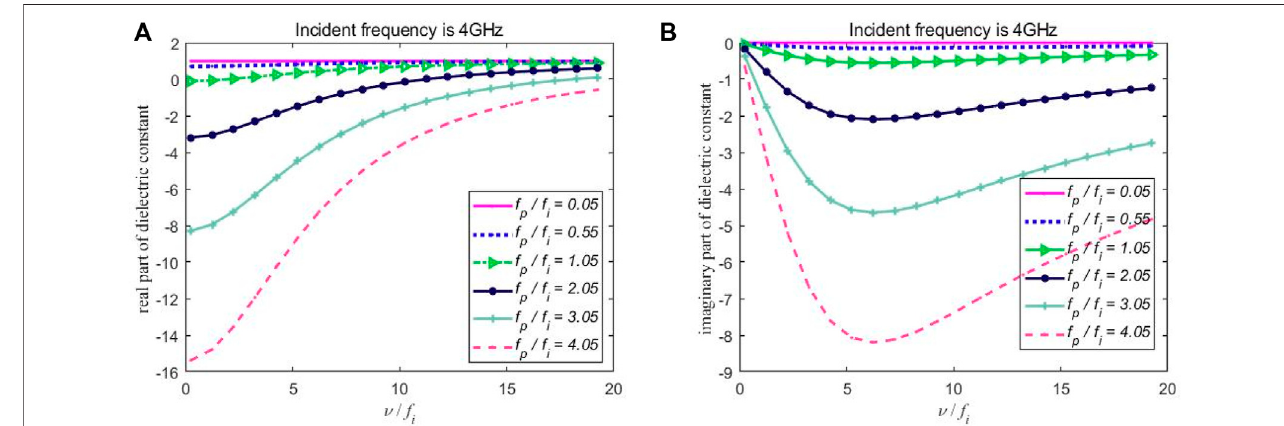
FIGURE 1 | The effect of different collision frequencies and plasma frequencies on the (A) real part of plasma permittivity and the (B) imaginary part of plasma permittivity.